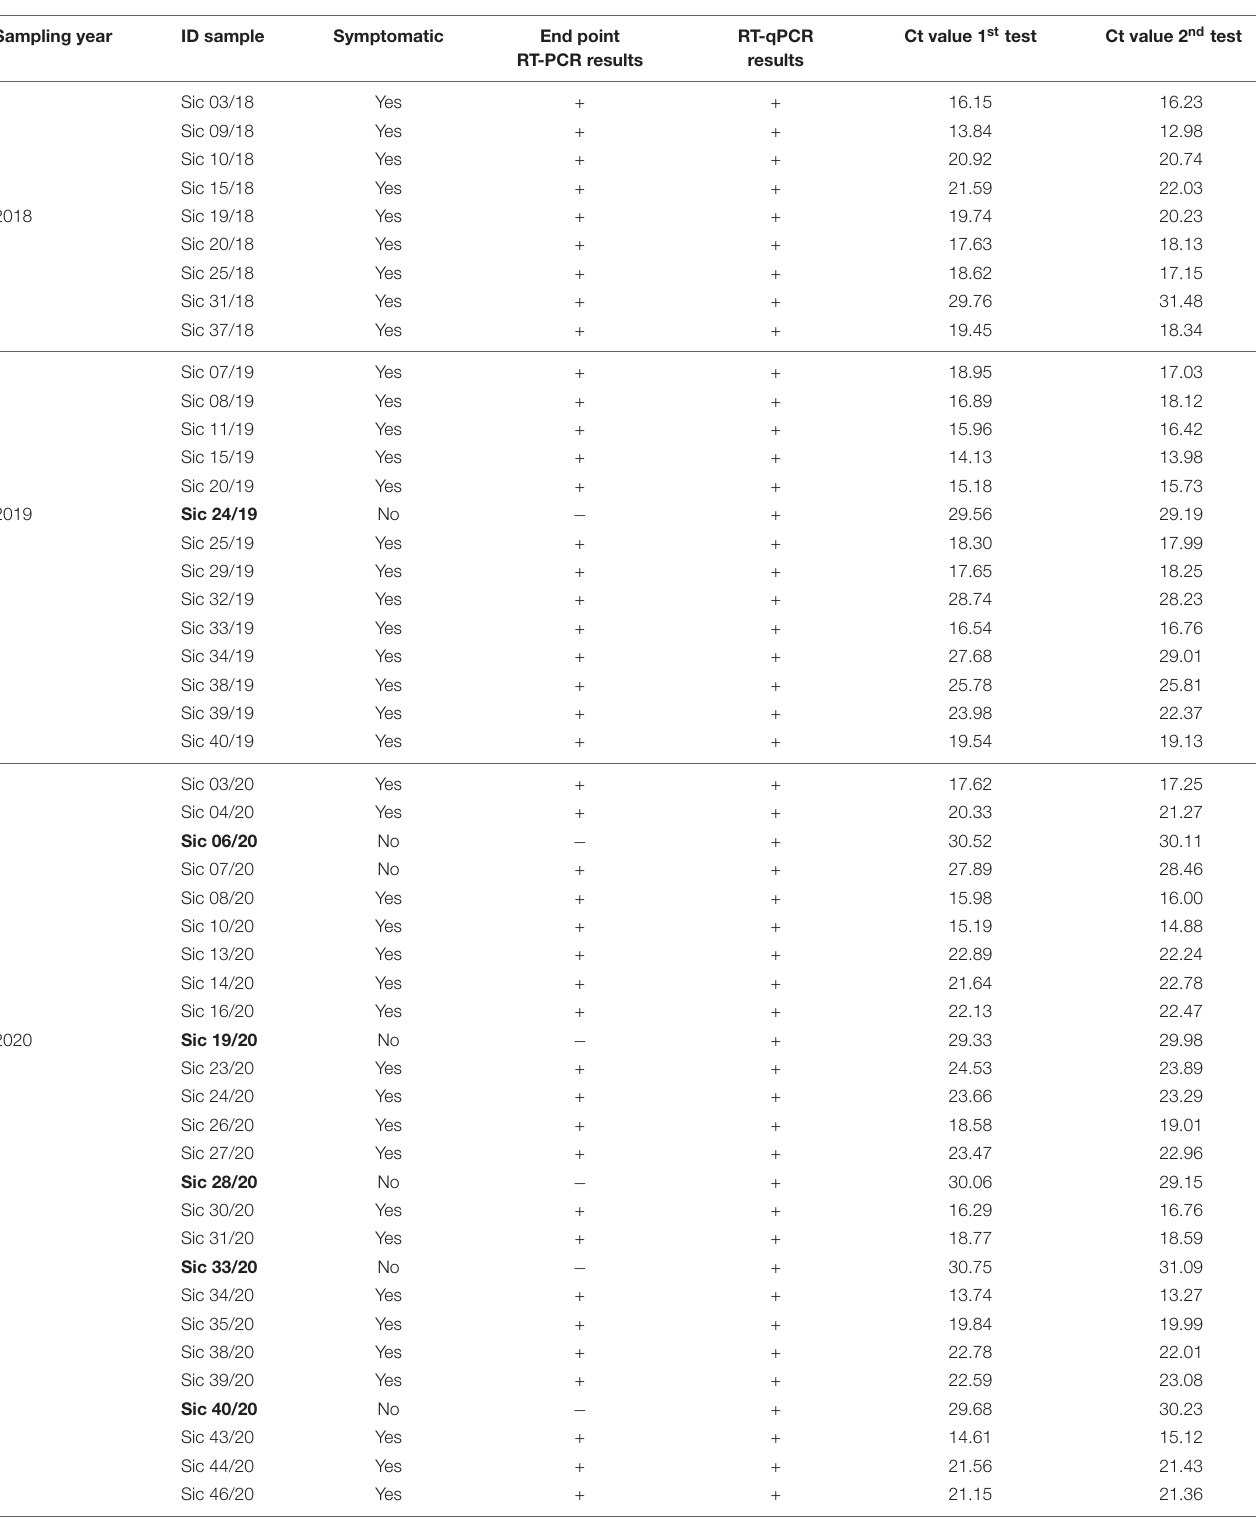
TABLE 5 | Comparison of positive field samples to RT-qPCR with end point RT-PCR results. Sampling